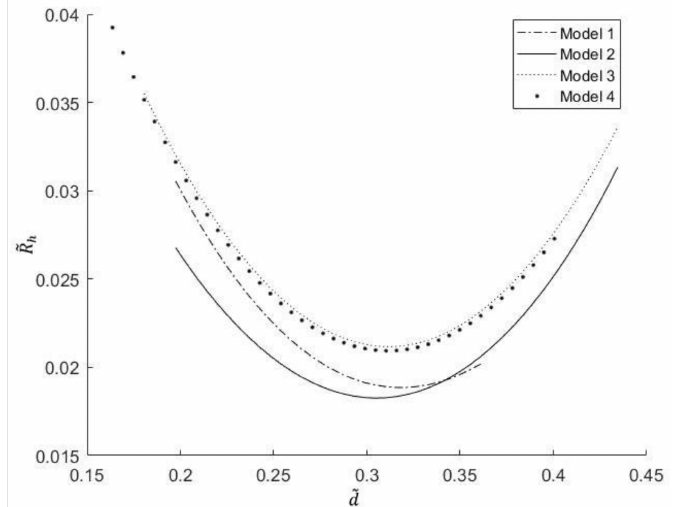
Figure 5. The relationship between (cid:101) R h and (cid:101) d of four models at ϕ = 15% and N = 3. Table 2. The relationship between the minimum value of (cid:101) R h and (cid:101) d in four models.